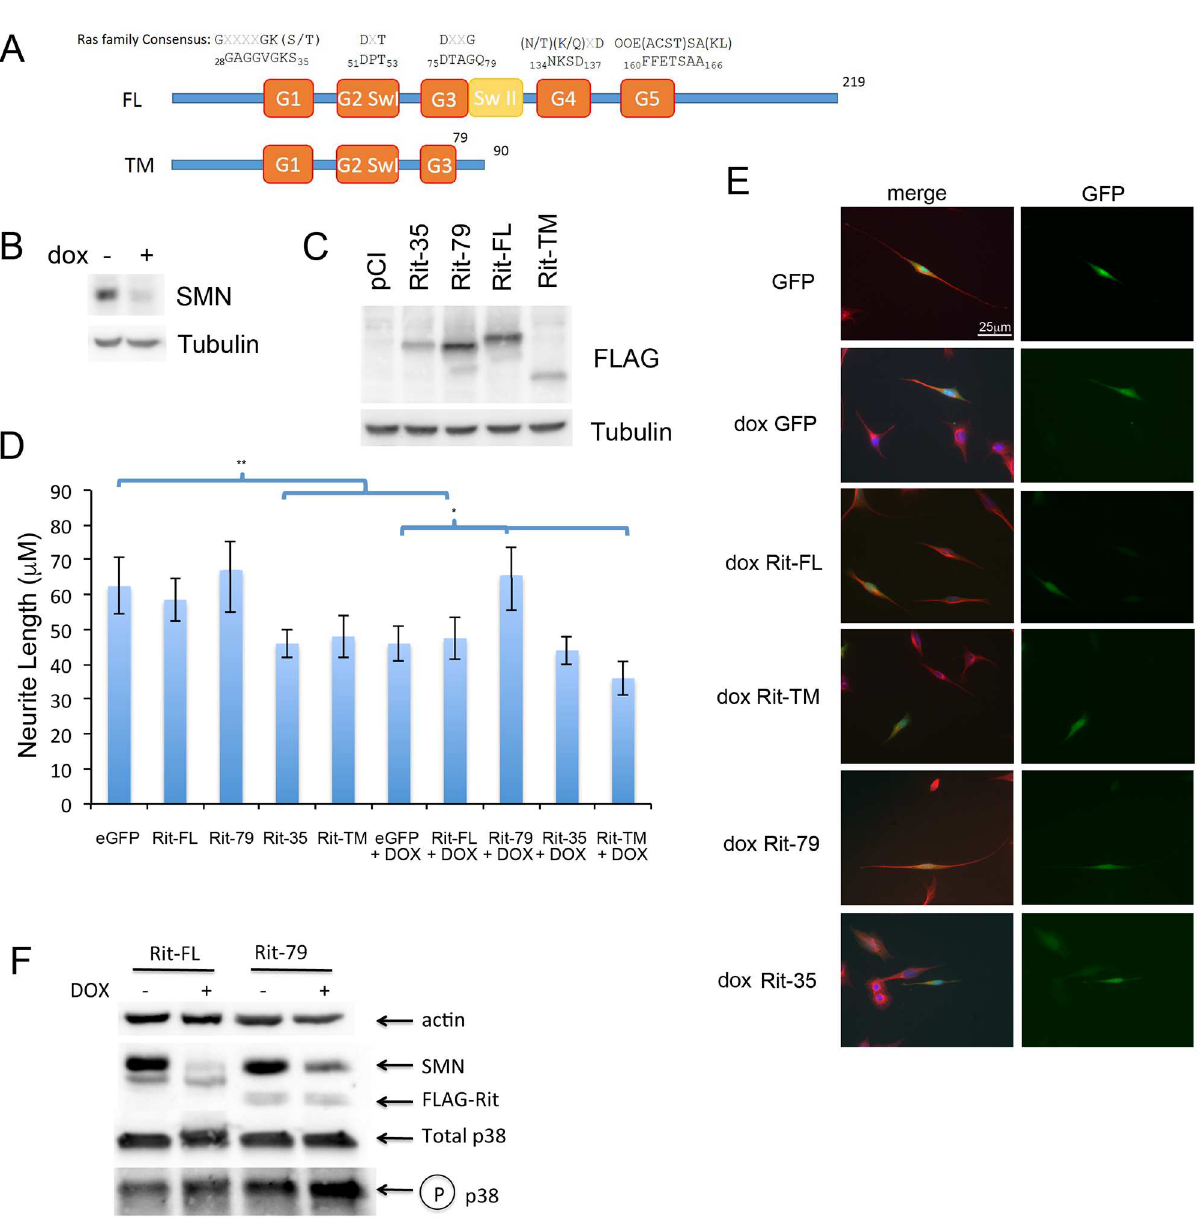
Fig 10. Alternatively spliced Rit1 decreasesneurite length. A) Schematic of Rit1 protein domains. Protein sequenceshown of minimal consensus G1-G5 domains of Ras family members on top followedby the mouse Rit1 specific sequence and corresponding amino acid position. SwI: Switch I, SwII: Switch II domains, FL: Full length, TM: truncation mutant. B) Representative levels of SMN for NSC34-4#56 cells used in panels D and E upon dox-induced knockdown. C) Western blot expressionof FLAG tagged dominant negative Rit S35N, constitutively active Rit Q79L, full length Rit (FL), and alternatively spliced Rit truncation mutant (TM). D) Neurite extension assay. NSC34- 4#56 cells were dox treated for 3 days followedby transfection of FLAG-Rit /GFP for 3 days. Cells were fixed and tubulin stained to allow neurite length measurement in GFP positive cells. Data are representative of three independent experiments, p < 0.001 as determined by one-way ANOVA and post-hoc Bonferroni test. ** : p < 0.01. E) Immunofluorescent images of representative cells. Red: Tubulin, Green: GFP, Blue: DAPI nucleus. F) Western blot from NSC-34 cells followingdifferentiation and 72 hours treatment with doxycycline. Transfection with Rit-79 but not Rit-FL increasedlevels of phospho-p38 and SMN in doxycycline-treated cultures.